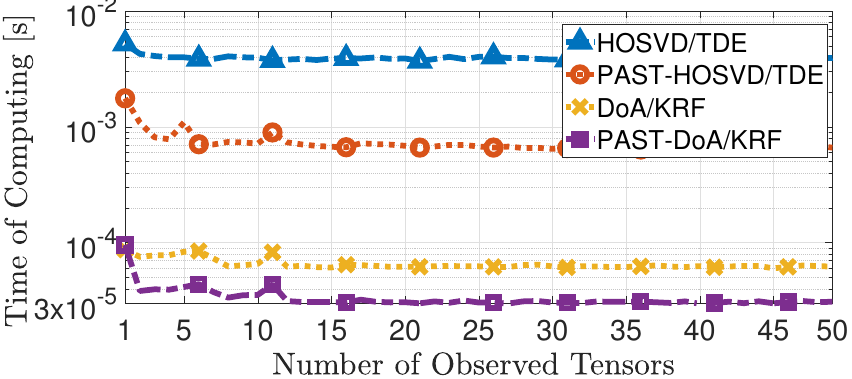
Figure 3. Comparison between the proposed techniques PAST–DoA/KRF and PAST-HOSVD/TDE and the state-of-the-art techniques DoA/KRF [11] HOSVD/TDE [10] in terms of Time of